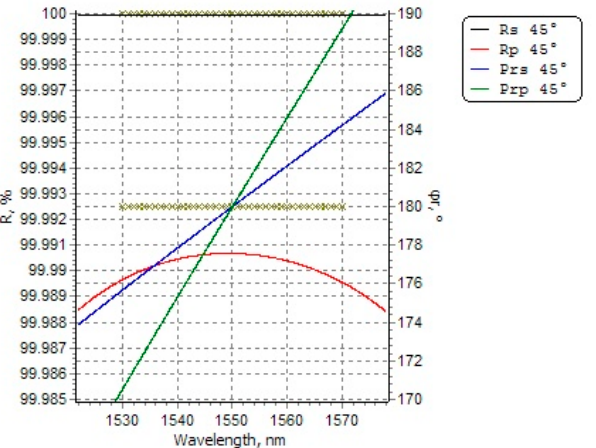
Figure 3. The simulation results of matrix calculation using the thin film software OptiLayer (version 8.85). The black line represents the reflection of S-polarized light at 45 ◦ oblique incidence; the red line represents the reflection of P-polarized light at 45 ◦ oblique incidence; the blue line the represents reflection phase of S-polarized light while the green line represents the reflection phase of P-polarized.